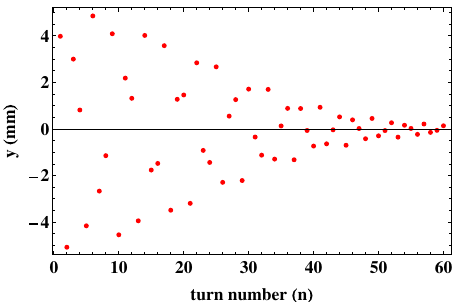
FIG. 4. Vertical offset of bunch centroid from closed orbit position at location of BPM vs turn number. A Gaussian momentum distribution with a standard deviation of 12 keV = c means that the betatron oscillation of the bunch centroid appears significantly damped within 60